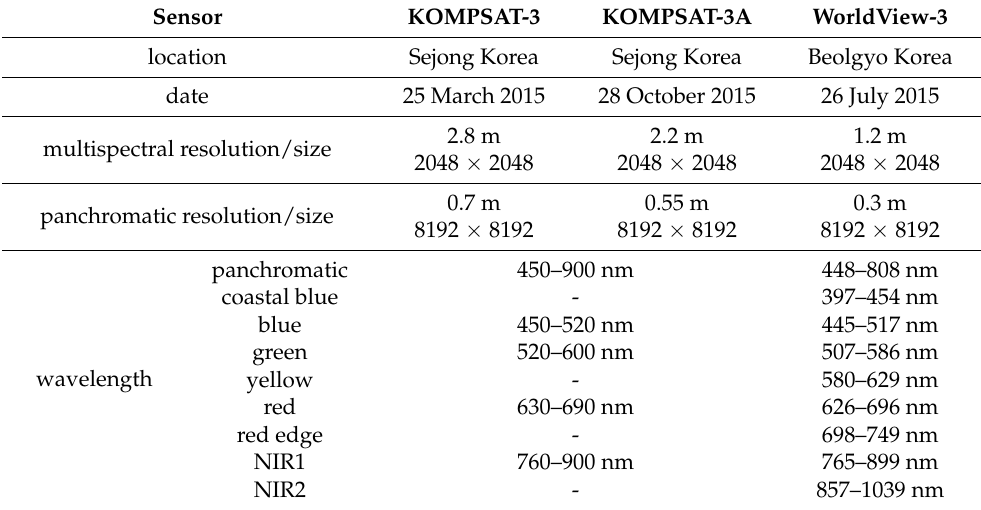
Table 2. Specifications of the satellite sensors and datasets used in this study. KOMPSAT, Korean Multi-Purpose